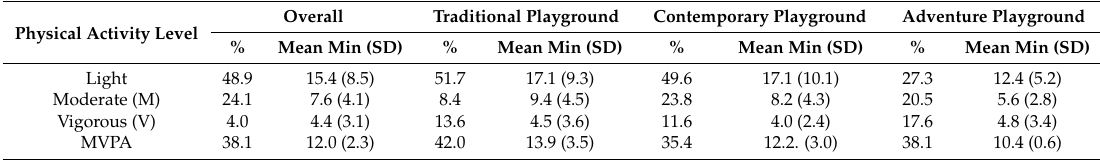
Table 1. Time spent in physical activity at each playground.